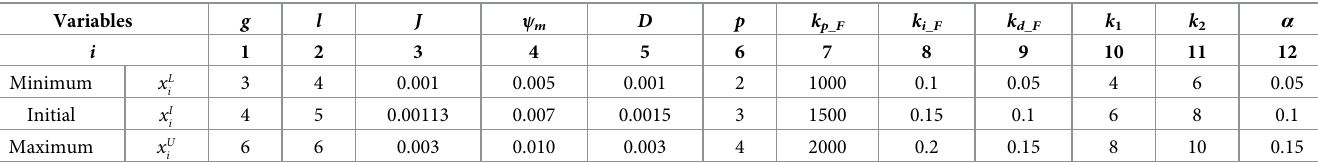
Table 8. Value bounds of the decision variables.